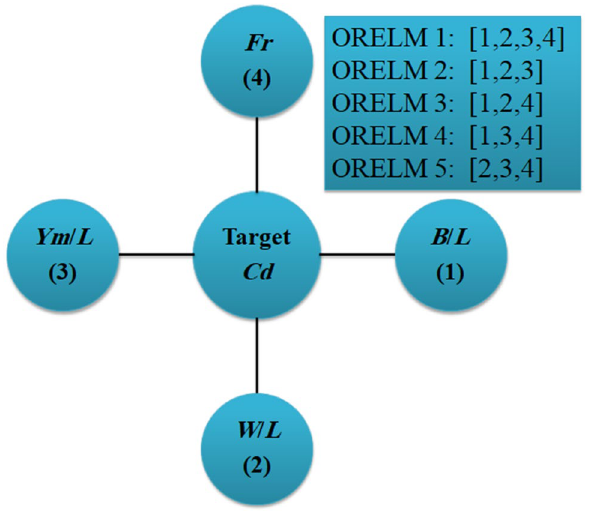
Fig. 2 Integrations of input variables for ORELM